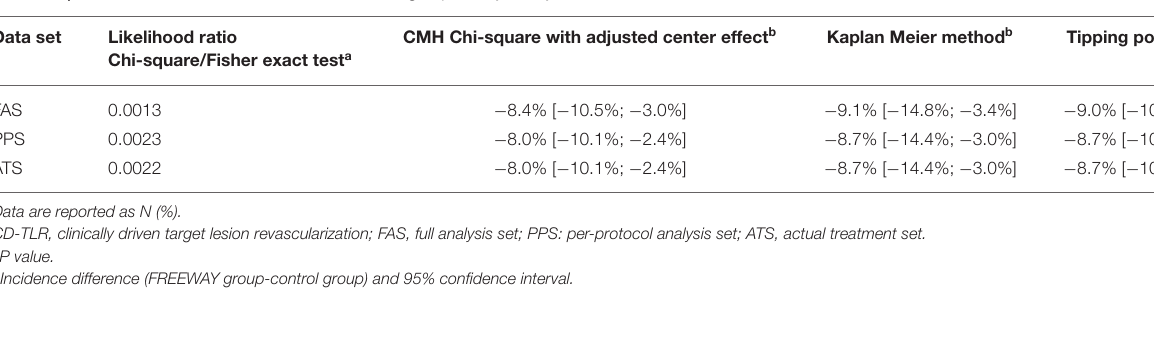
TABLE 4 | The 6-month CD-TLR rate difference of two groups analyzed by different